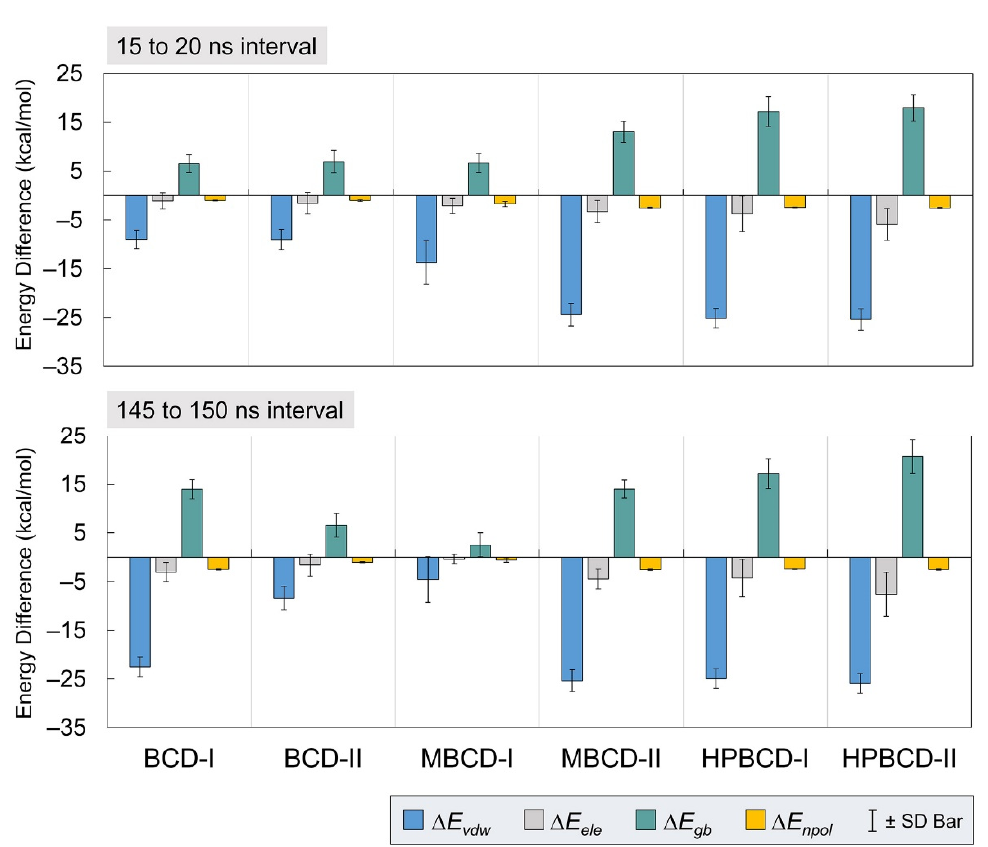
Figure 4. Plots of energetic contributions from two stable intervals. The van der Waals ( ∆ E vdw ) and electrostatic ( ∆ E ele ) energies, which contribute to average interaction energy, are presented as blue and gray bars, respectively. The electrostatic ( ∆ E gb ) and nonpolar ( ∆ E npol ) energies, which contribute to solvation-free energy, are presented as teal and yellow bars, respectively. The error bar is included for each bar plot to represent the standard deviation values. Table 1. Binding energies of all inclusion complexes, presented with major energetic components in kcal/mol from MM/GBSA calculation during two stable intervals.